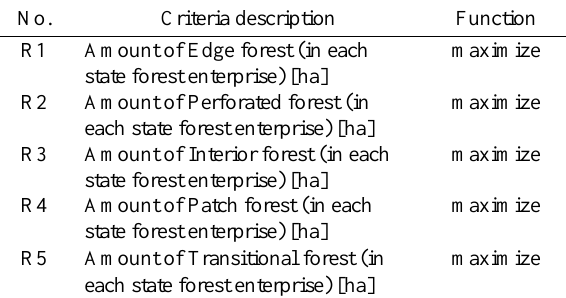
Table 1. Importance of criteria No.